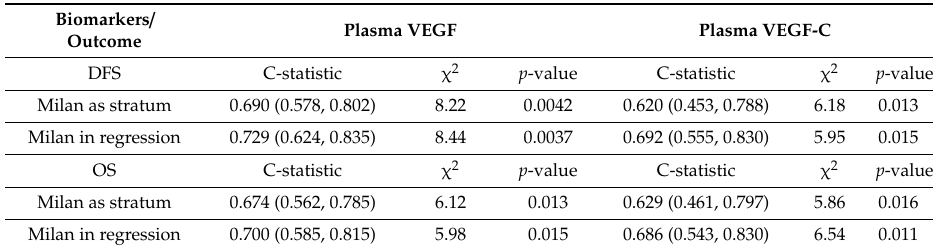
Table 7. Analysis of plasma VEGF and VEGF-C combined with Milan criteria and AFP in hepatocellular carcinoma patients who underwent liver transplantation. Analysis was performed in proportional hazards regression model, with log-transformed VEGF or VEGF-C and AFP measurements and either stratifying on Milan criteria as a stratum variable or including Milan criteria in regression. Data are presented as C-statistic with 95% confidence